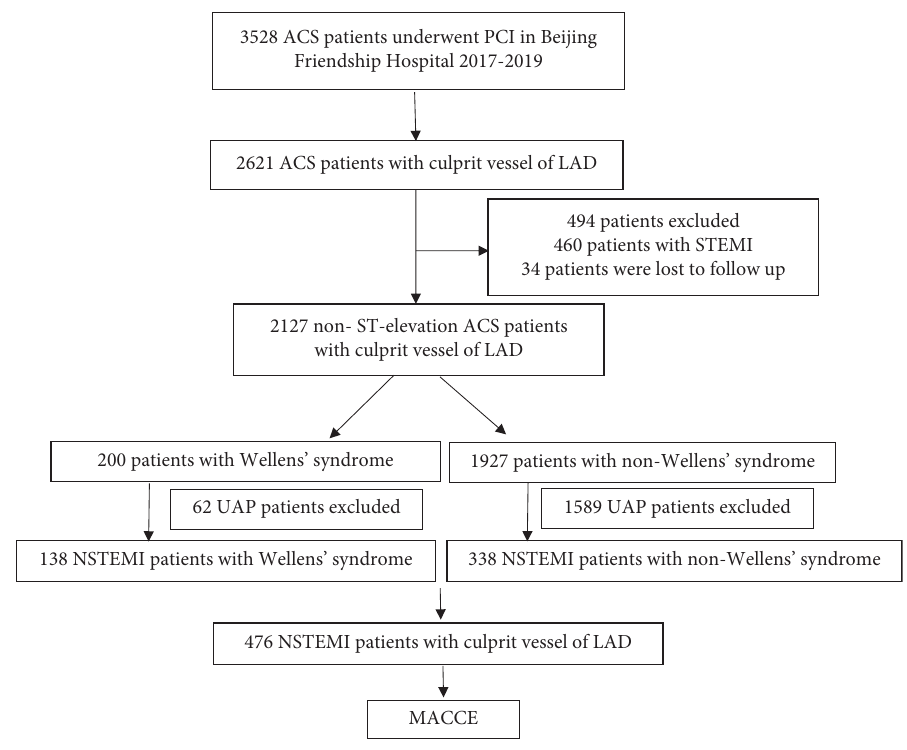
Figure 1: Flowchart of patient